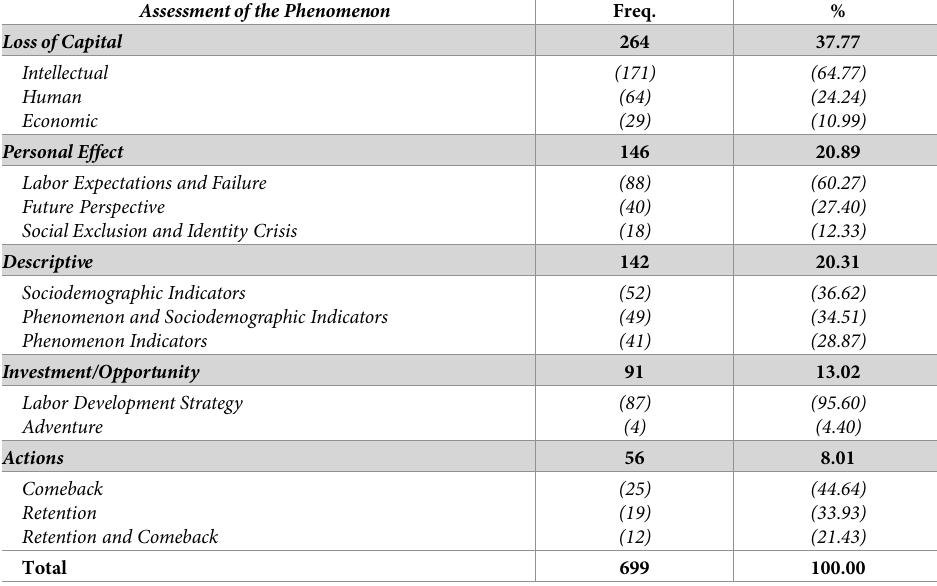
Table 11. Distribution of articles by assessment of the